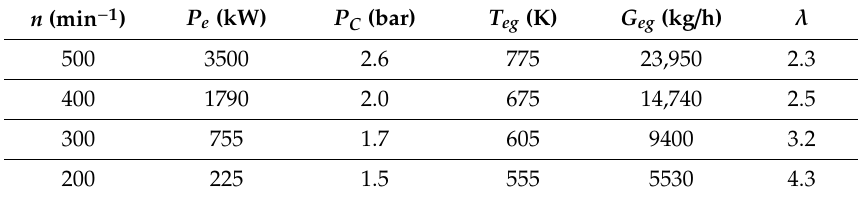
Table 1. Performance indicators of a six-cylinder four-stroke engine (bore / stroke 30 /